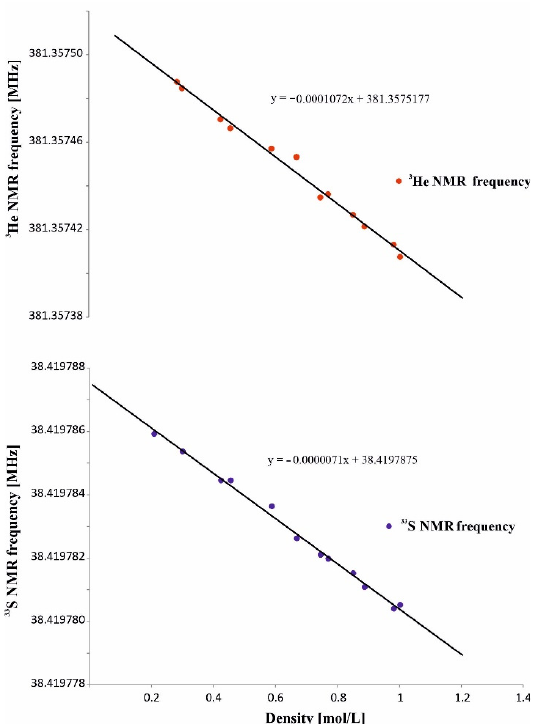
Figure 3. 3 He and 33 S NMR frequencies as a density function of the gaseous mixture 3 He-SF 6